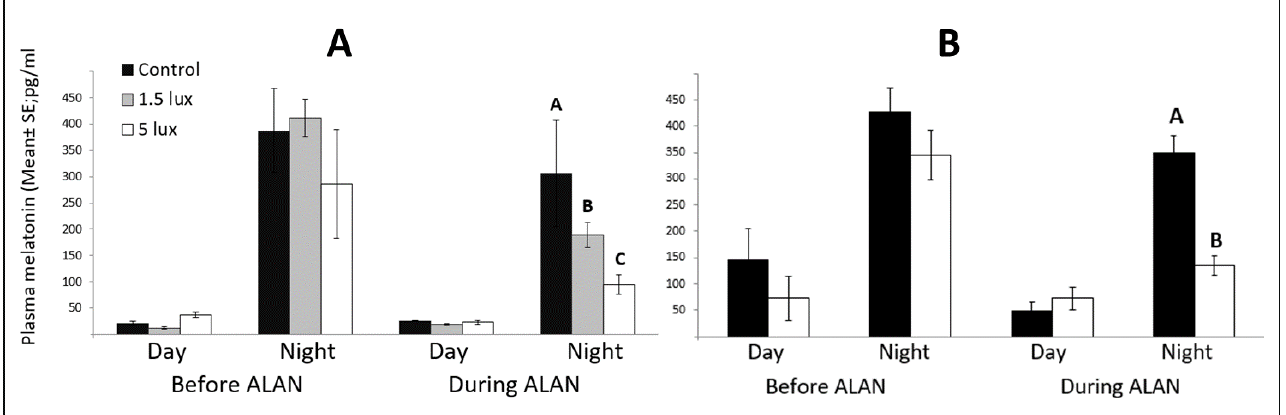
Figure 9. Day and night plasma melatonin levels (pg/mL; Mean ± SE) before and after exposure to ALAN (1.5, 5 lux), compared with controls that were kept under dark nights in ( A ) proliferation (n = six birds per group); and ( B ) neuronal recruitment (n = eight birds per group) experiments. Different letters indicate significant differences ( p < 0.05, Tukey post hoc tests following one-way ANOVAs between groups). Groups with no letters are not significantly different.